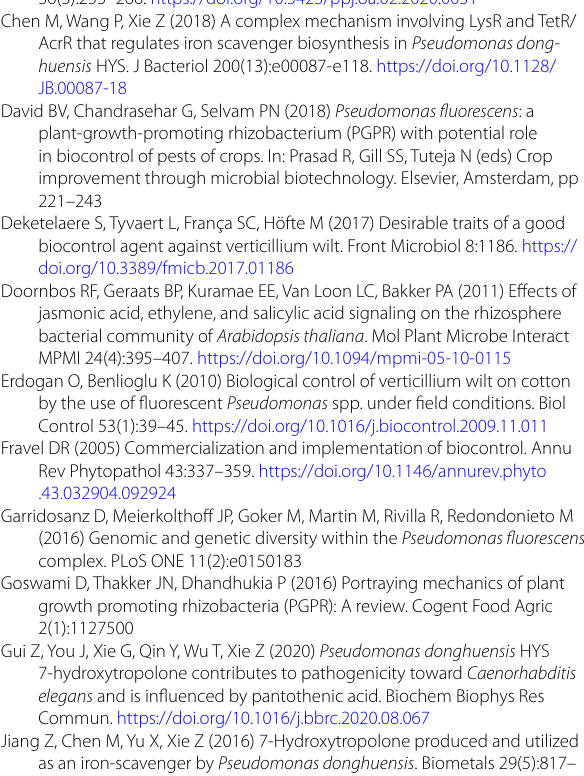
study. Table S3. Genome summary of Pseudomonas strains. Table S4. RAST Annotation of unique genes in XY2F4. Table S5. RAST Annotation of unique genes in